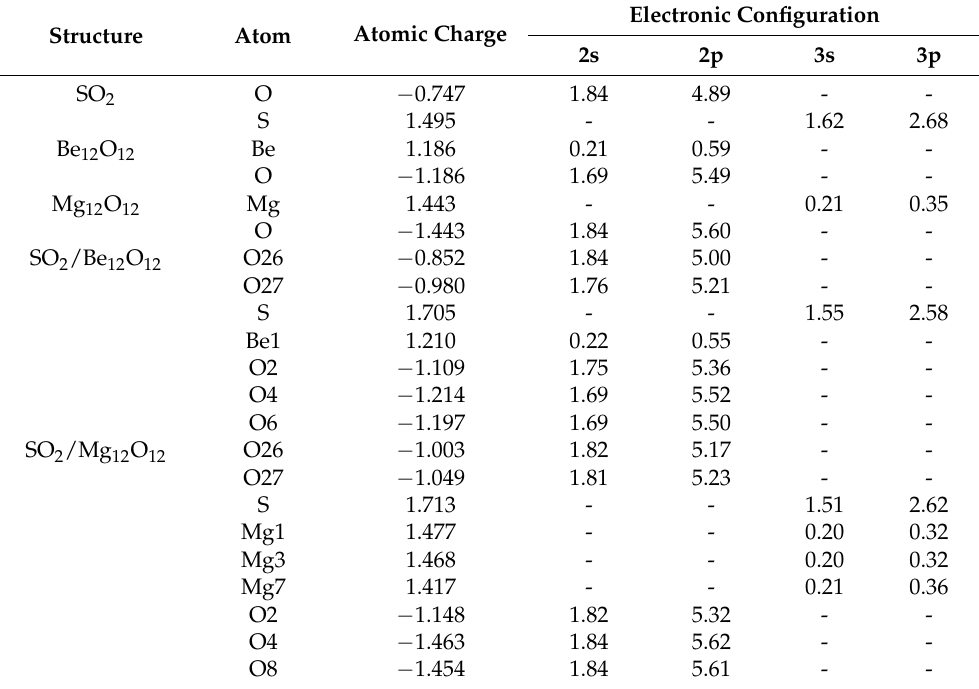
Table 4. NBO charges (Q, e) and electronic configuration for free SO 2 , Be 12 O 12 , Mg 12 O 12 , SO 2 /Be 12 O 12 , and SO 2 /Mg 12 O 12 .